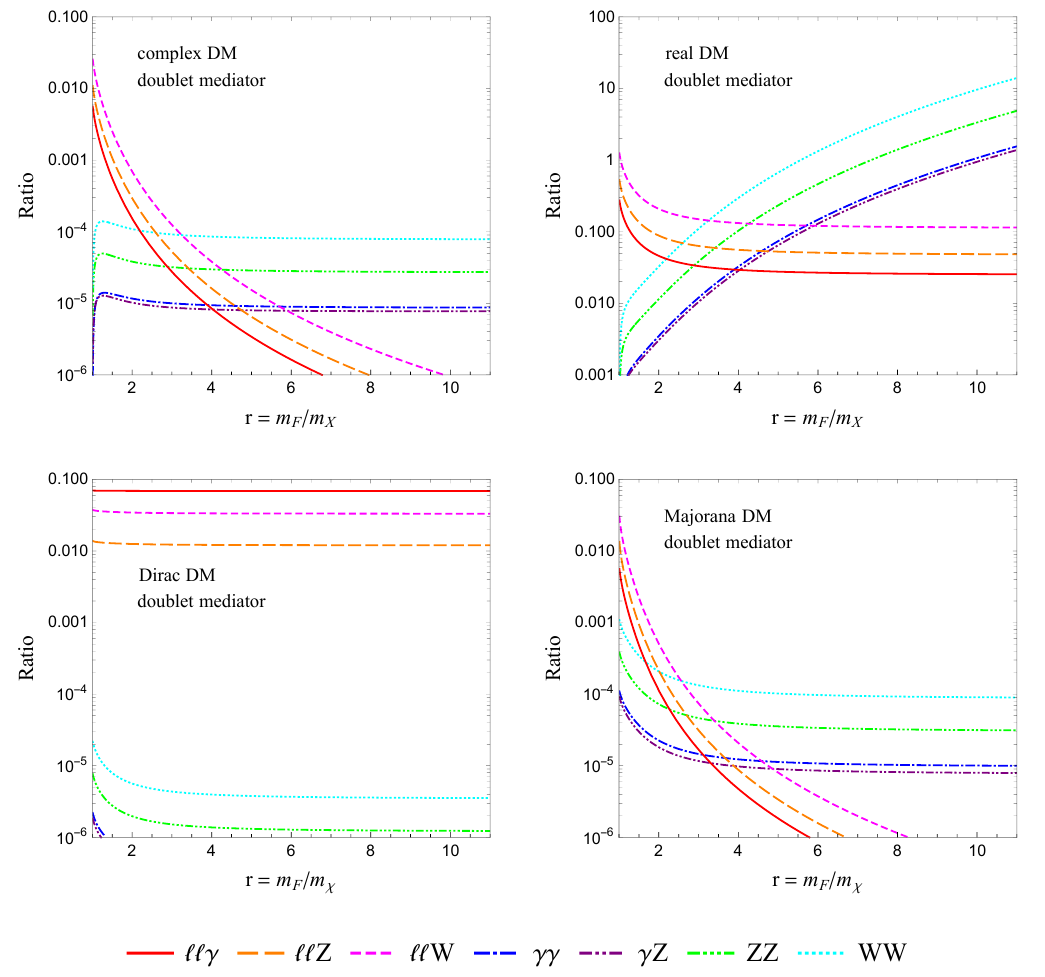
Figure 4 . Ratio of cross section in the complex (top-left), real (top-right), Dirac (bottom-left) and Majorana (bottom-right) DM models. We assume the SU(2) L doublet mediators and the muon-philic coupling. The DM mass is (cid:12)xed at 500 GeV in all cases and DM velocity is set to the thermal averaged values at the freeze-out: